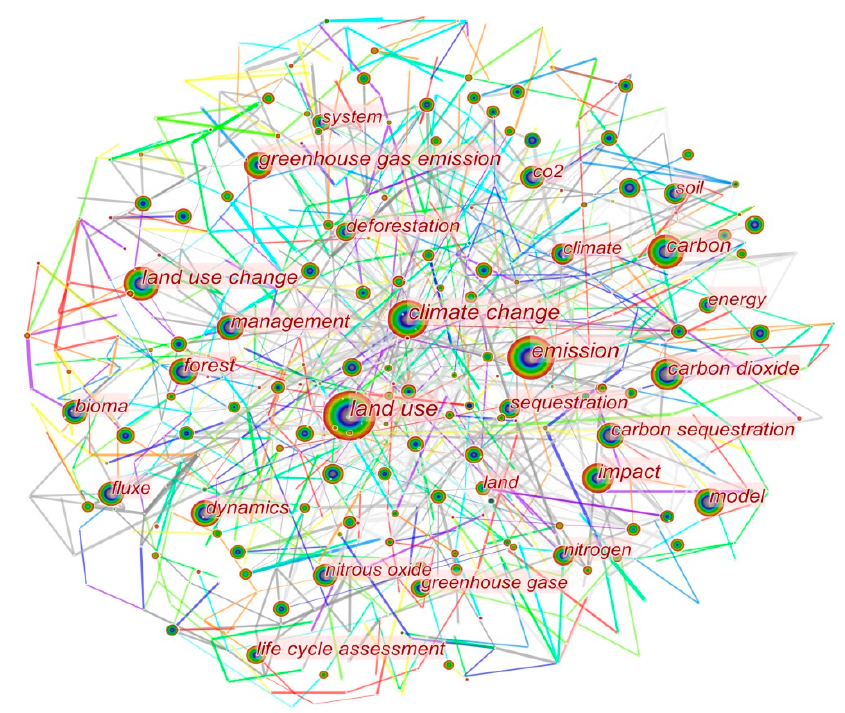
Figure 7. Co-occurrence graph of keywords for carbon emissions research in the WoS database.